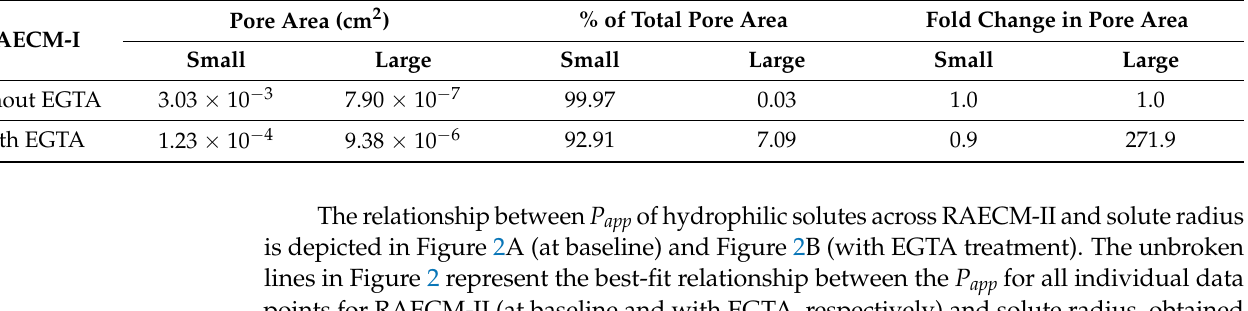
Table 5. Small and large equivalent pore areas and their fractions and fold changes in equivalent pore area in response to EGTA treatment of RAECM-I. Equivalent pore characteristics in response to EGTA treatment. Entries are based on the estimated values listed in Table 4. Equivalent pore area is per nominal surface area (1 cm 2 ) of RAECM-I. Pore Area (cm 2 ) % of Total Pore Area RAECM-I